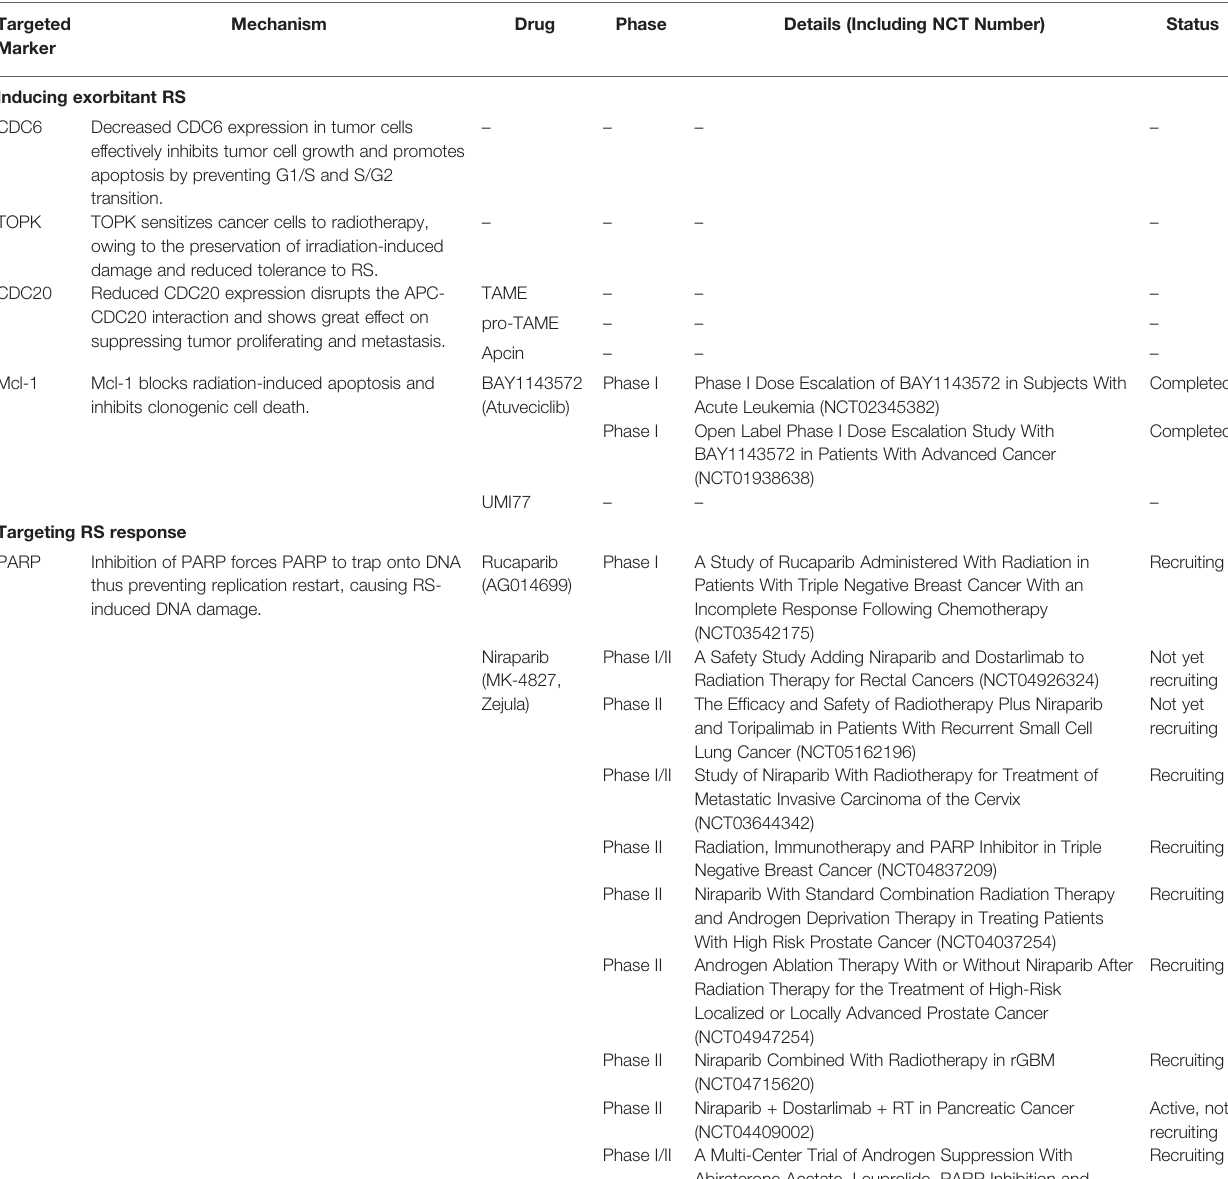
TABLE 1 | Targeting replication stress as radiation